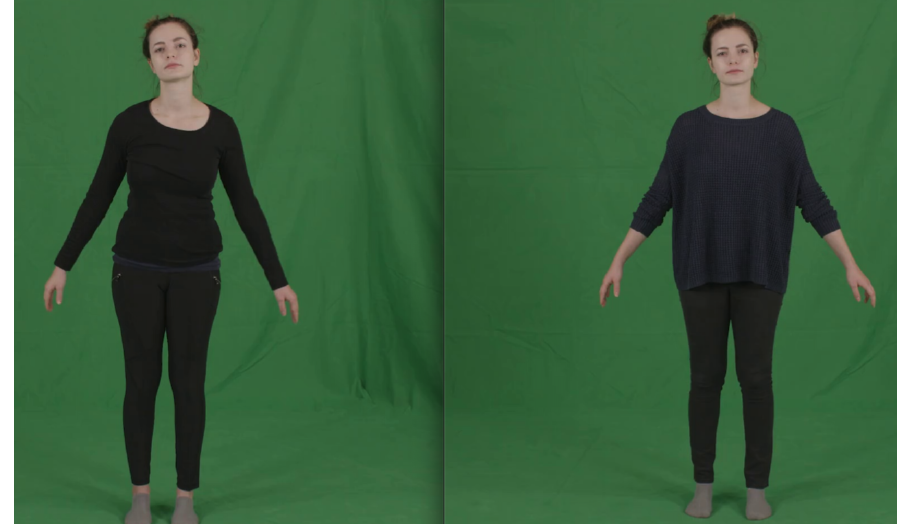
Figure 3. Samples of a same subject in the People Snapshot dataset. The “minimally clothed” version (with tight clothes) is shown on the left , and is used to estimate the shape parameters. These parameters are then assigned to the other sequences with looser clothes ( right